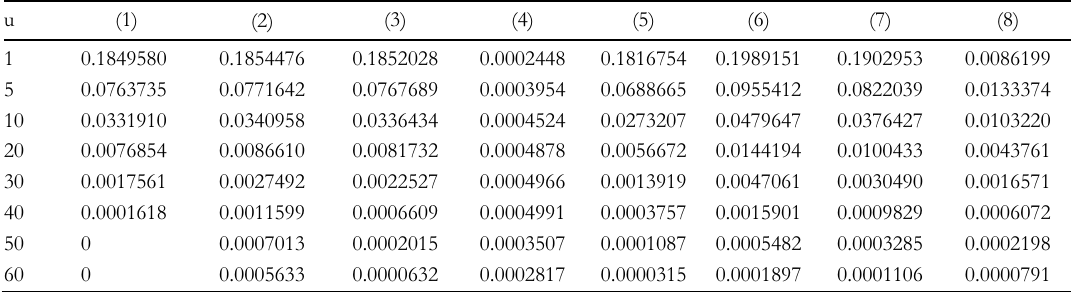
Inverse Gaussian, with mean 1 , variance 5 and (cid:84) = 2.5, using (cid:39) (cid:32)